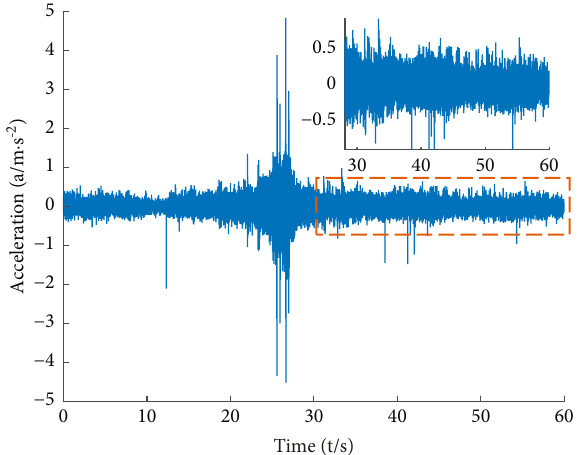
Figure 4: Measured vertical acceleration time domain diagram of hinge